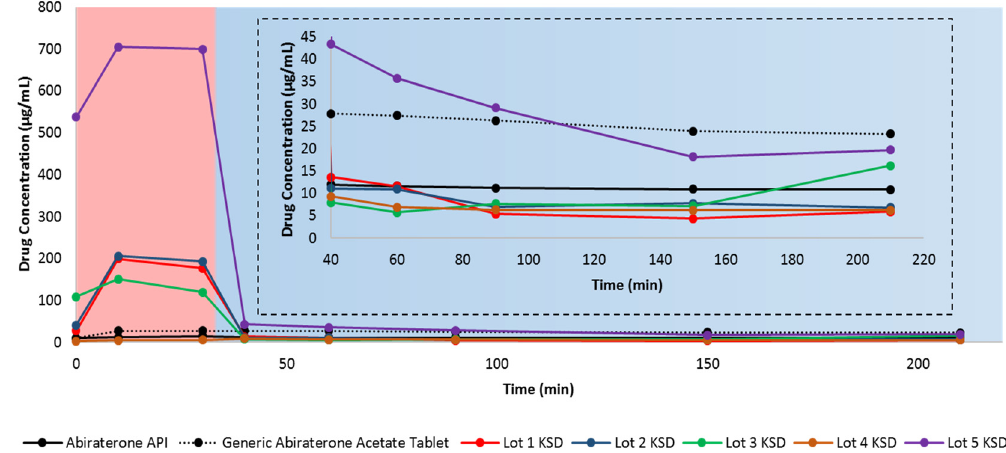
Figure 5. In vitro, non-sink, gastric transfer dissolution profiles of neat abiraterone API, generic abiraterone acetate tablets, and binary KSDs. The red region: 0.01 N HCl. The blue region: FaSSIF. The inset represents the enlargement of the dissolution profile in FaSSIF.